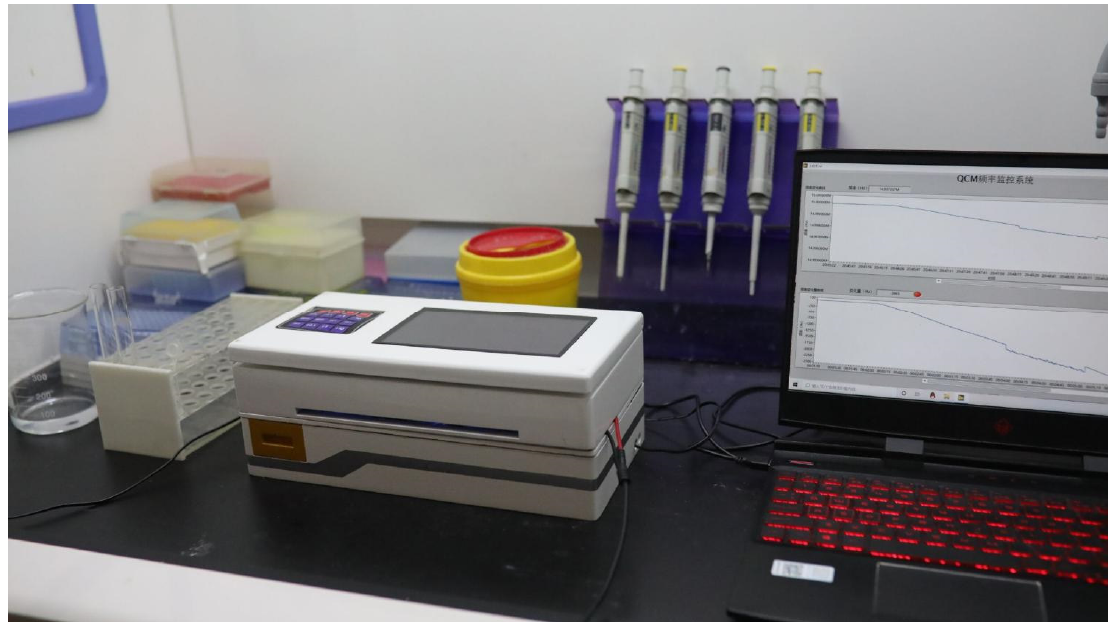
Figure 7. RNA virus experimental platform.